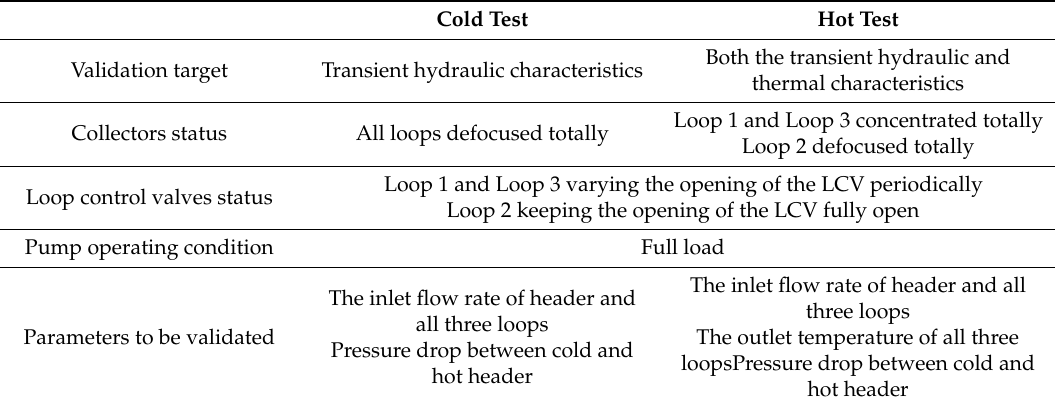
Table 3. The detailed summarized information of the two tests.